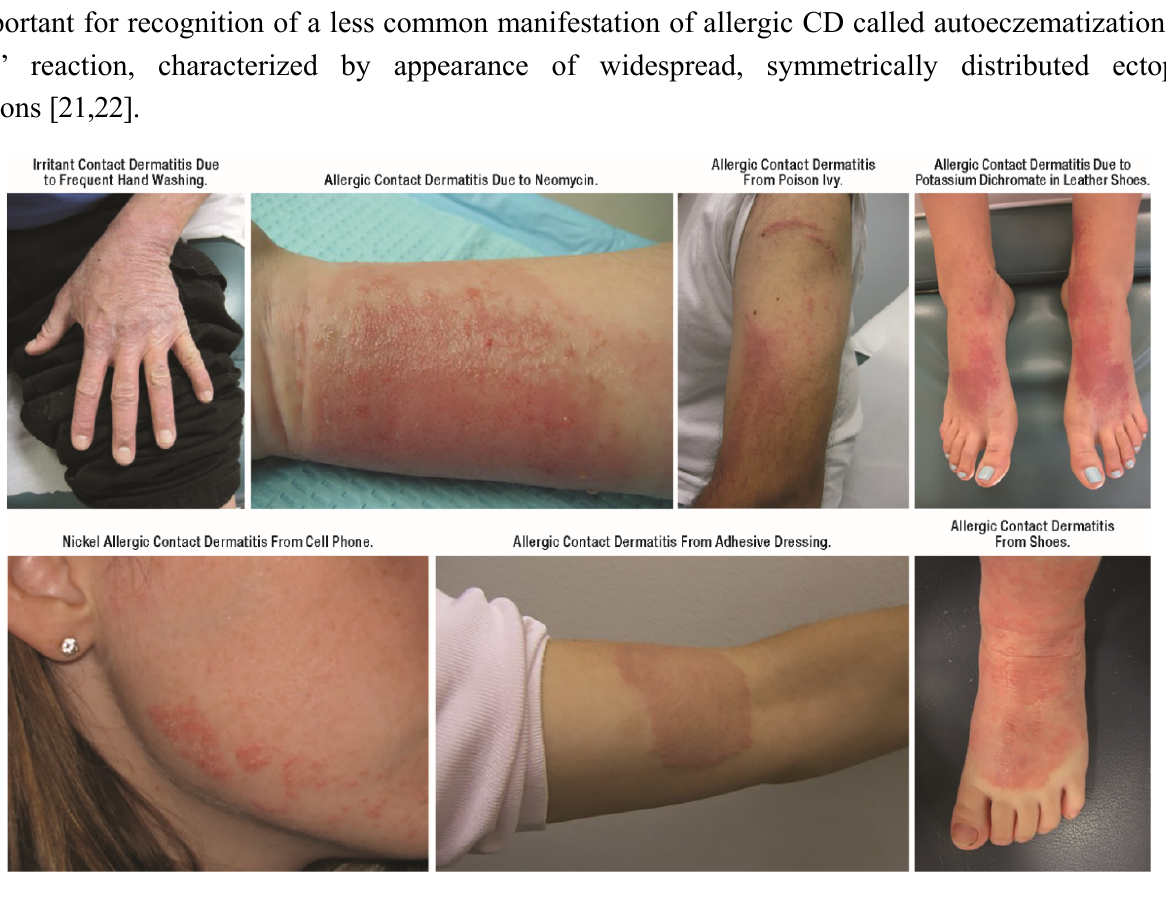
Figure 4. Contact